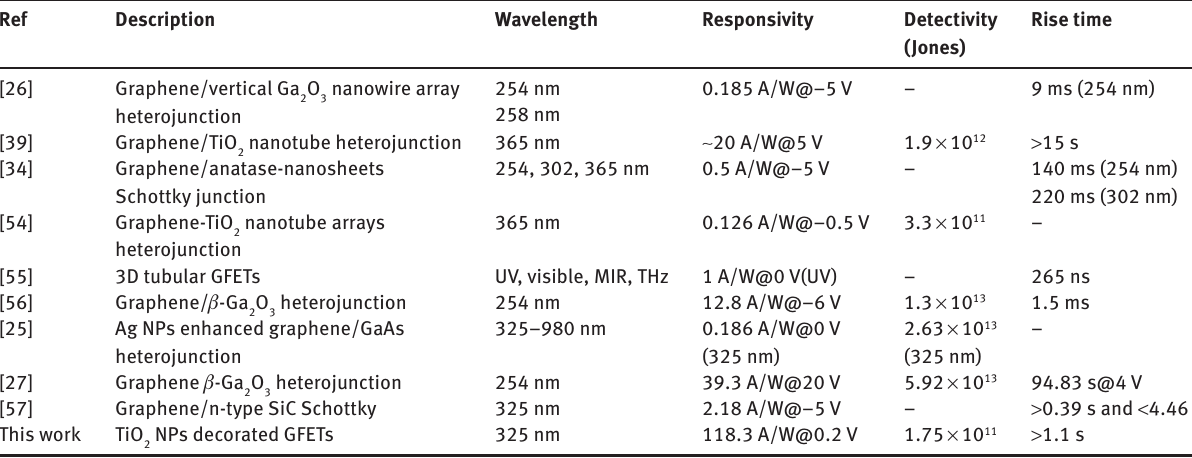
Table 2: Photoelectrical characteristics of typical ultraviolet (UV) photodetectors based on